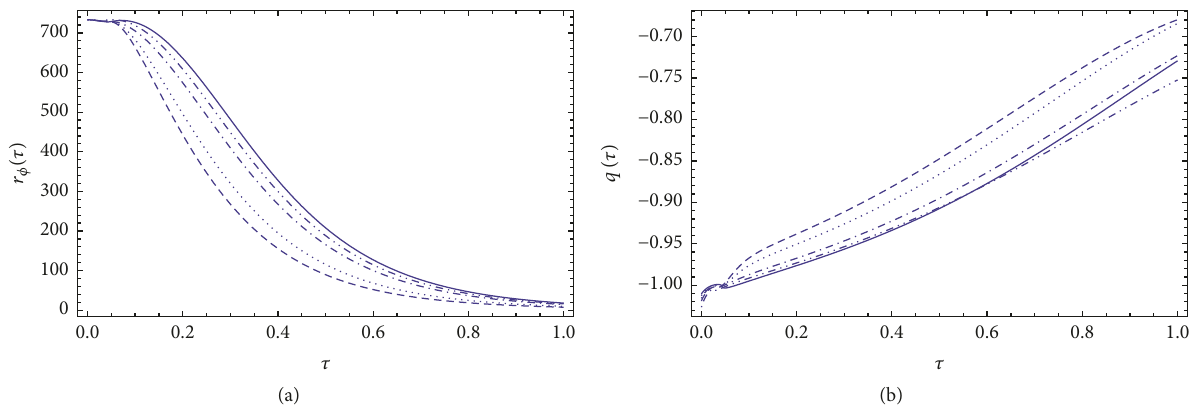
Figure 8: Time variation of the energy density of the Higgs type scalar field (a) and of the deceleration parameter (b) during the reheating period with irreversible particle creation for different values of 𝛼 𝜙 : 𝛼 𝜙 = 1.00 (solid curve), 𝛼 𝜙 = 1.20 (dotted curve), 𝛼 𝜙 = 1.40 (dash dotted curve), 𝛼 𝜙 = 1.60 (dashed curve), and 𝛼 𝜙 = 1.80 (dash double dotted curve), respectively. For the potential parameters 𝜇 and ] we have adopted the values 𝜇 = 2 and ] = 3 , respectively. The initial conditions used to numerically integrate (105) are 𝜙(0) = 10.5 , 𝑢(0) = −0.05 , 𝑁 (0) = 100 , 𝑟 (0) = 0 , and 𝑟 (0) = 0 , 𝜙 DM m